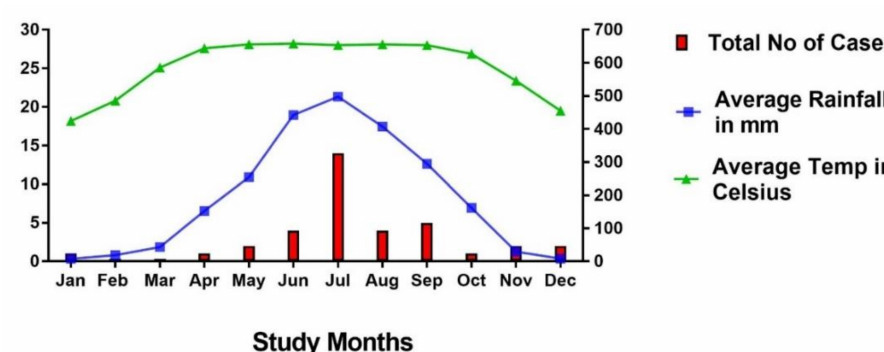
Figure 2. The monthly cases of culture-confirmed melioidosis, the average rainfall in mm, and the average temperature in degrees Celsius. Data represented from 1961 to 2015